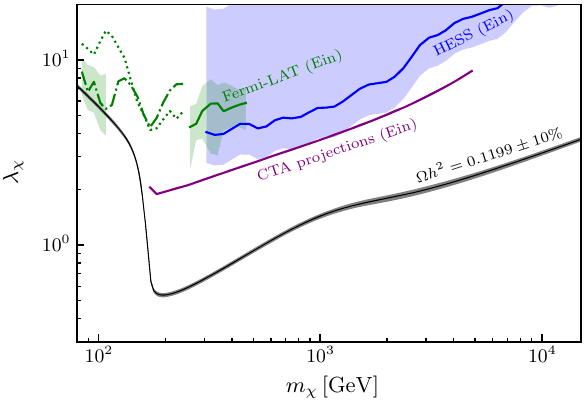
Fig. 1 Parameter space for the top-philic model, including the con- straints for loop-induced dark-matter annihilation into monochromatic photons. The black solid curve (and shaded band around it) shows the dark-matter coupling that yields the measured relic density, assuming Ω h 2 = 0 . 1199 (with a 10% uncertainty on the theory prediction), taken from[56].Thegreen(blue)curvedenotestheFermi-LAT(HESS)limits for the Einasto profile. The lower and upper boundaries of the shaded bands indicate the corresponding limits for the NFWc and Isothermal profile, respectively. The dotted and dot-dashed curves show the upper limits for the individual final states γγ and γ Z , respectively, in the range where the signals are not combined (see text for details). The purple curve shows projections for CTA assuming the Einasto